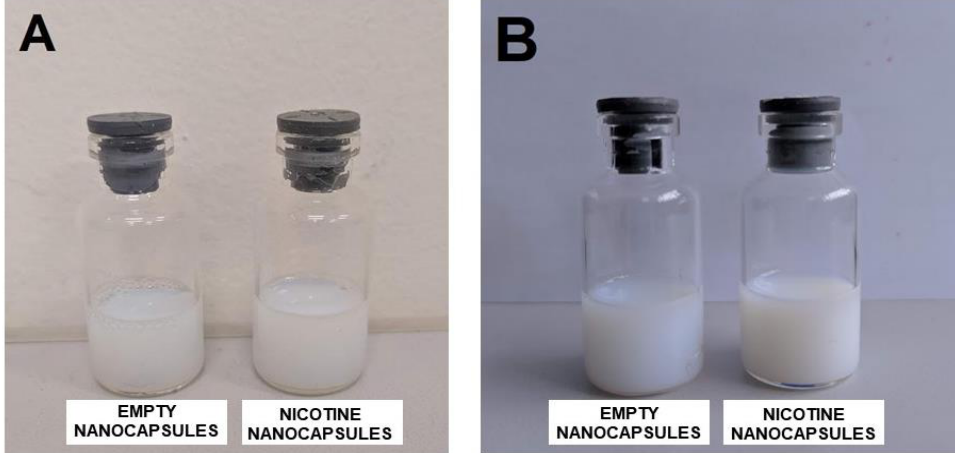
Figure 1. ( A ) Samples of freshly made Eudragit empty nanocapsules (left flask) and Eudragit nanocapsules containing nicotine (right flask); ( B ) samples of Eudragit empty nanocapsules (left flask) and Eudragit nanocapsules containing nicotine (right flask), 75 days after preparation, left at room temperature (25 ◦